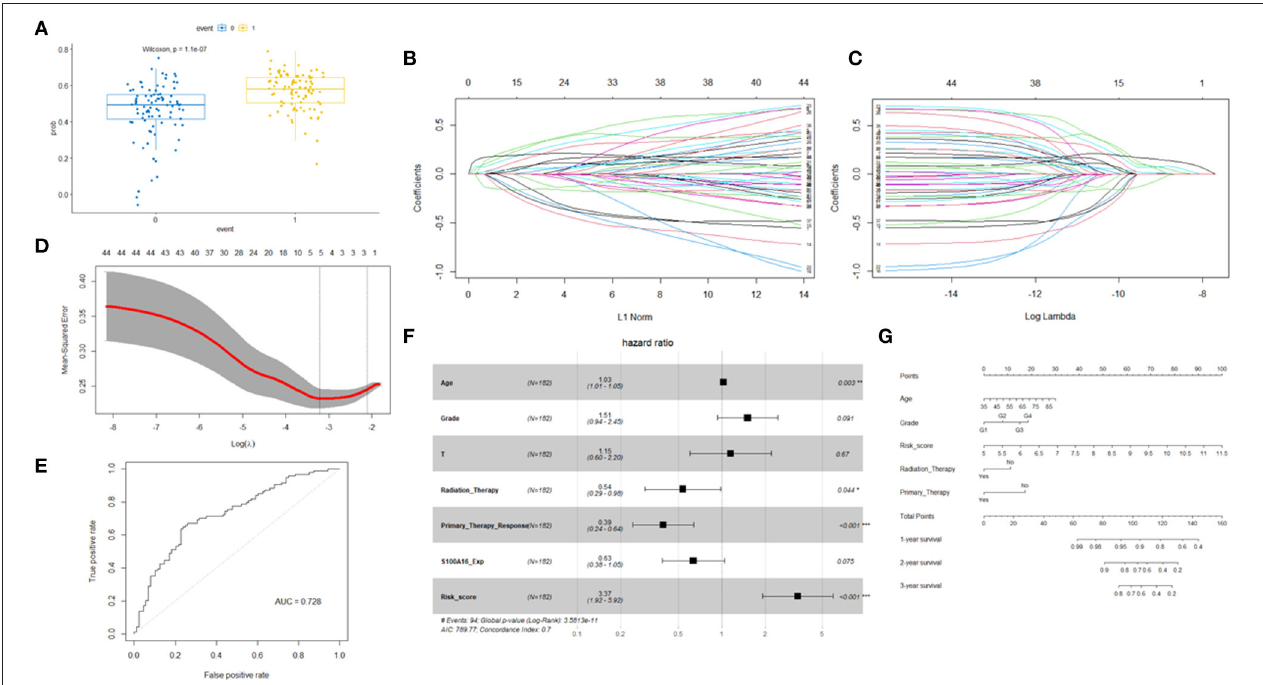
FIGURE 11 | Wilcoxon signed-rank test was performed to determine whether these gene sets were related to patient prognosis. (A) Least absolute 1 shrinkage and selection operator (LASSO) regression was performed. (B,C) Calculating the minimum criteria. (D) ROC curves for prognostic models. (E) Univariate and multivariate analyses revealed that risk score was an independent prognostic predictor in the TCGA datasets. (F) Nomogram based on risk score, age, WHO grade, radiation therapy, and primary therapy (G)